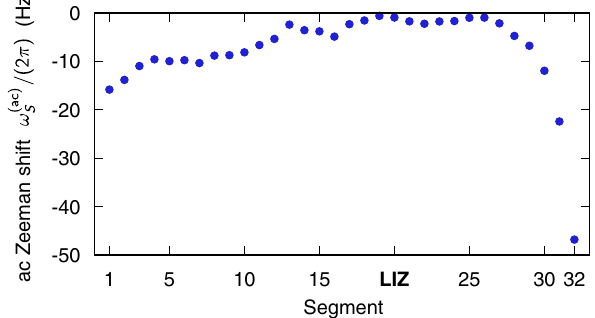
sensor state due to the ac = 2 1 = 2 and D 5 = 2